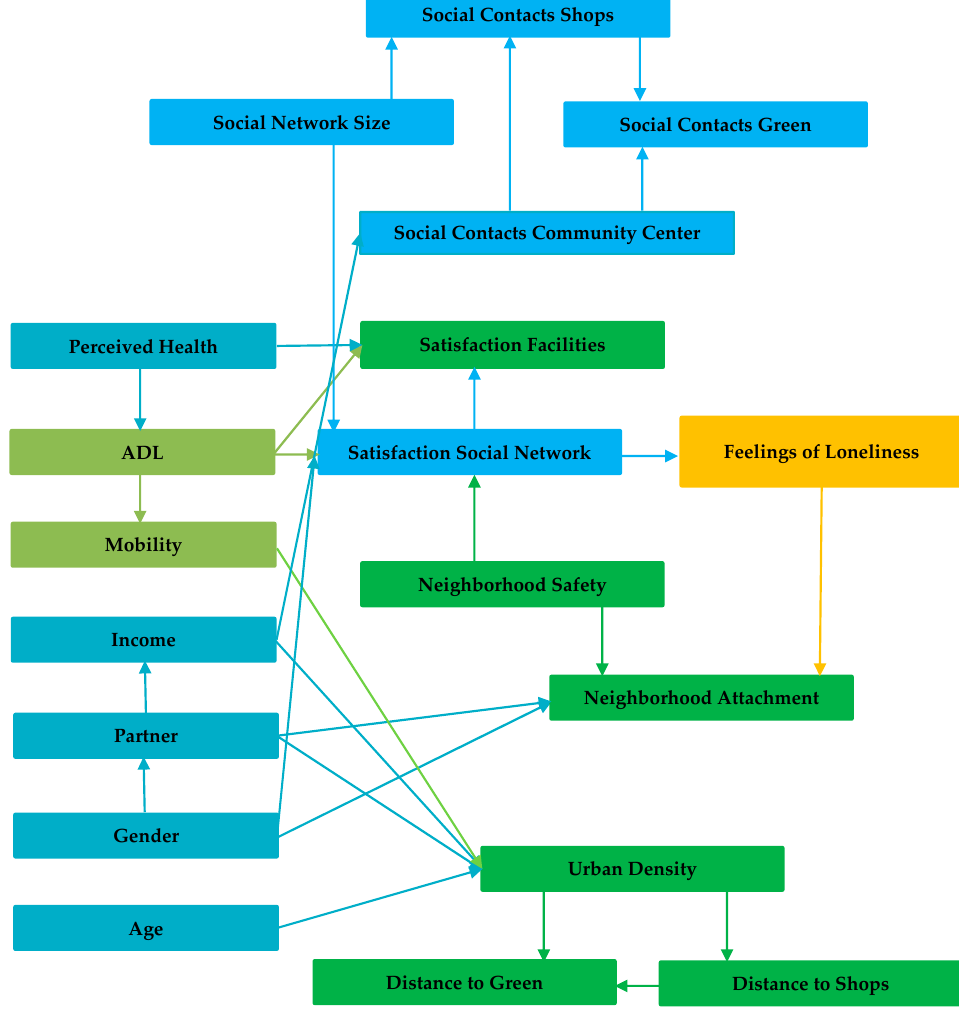
Figure 2. Bayesian belief network model. ADL: activities of daily living.